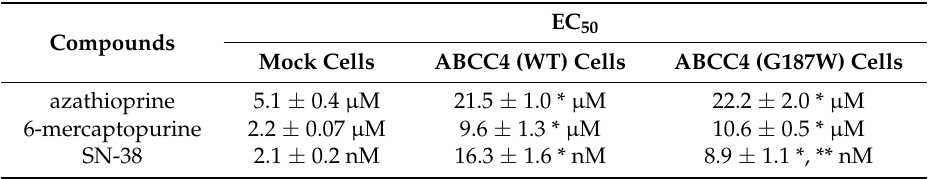
Table 2. Anticancer drug resistance profiles (EC 50 ) of the cells. Compounds